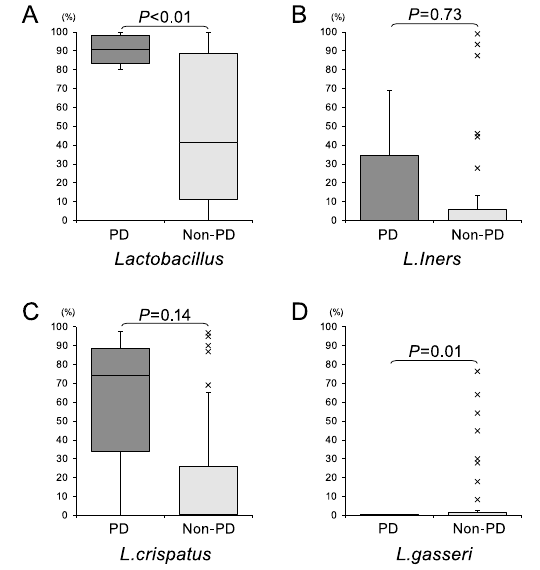
Figure 4 Comparative analysis of the relative abundance of Lactobacillus strains in the vaginal microbiome between the PD and non PD groups. A. Lactobacillus genus; B. L. iners ; C. L. crispatus; and D. L. gasseri .